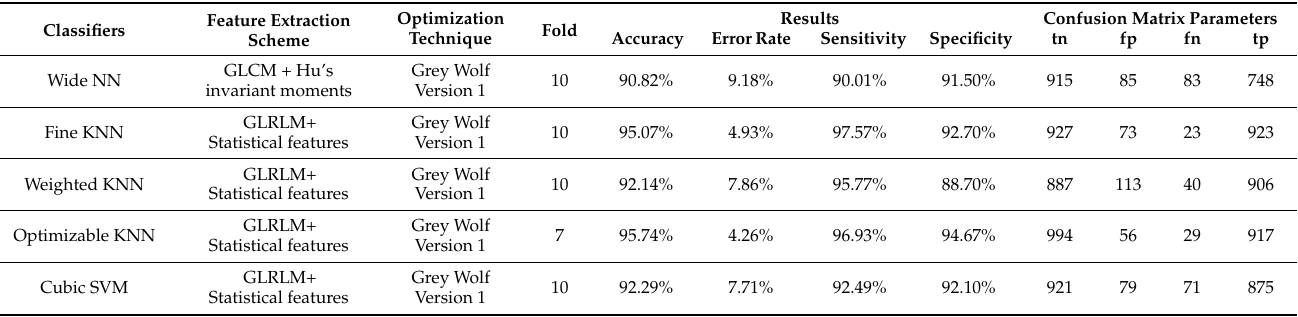
Table 10. The maximum performance of each classifier in our